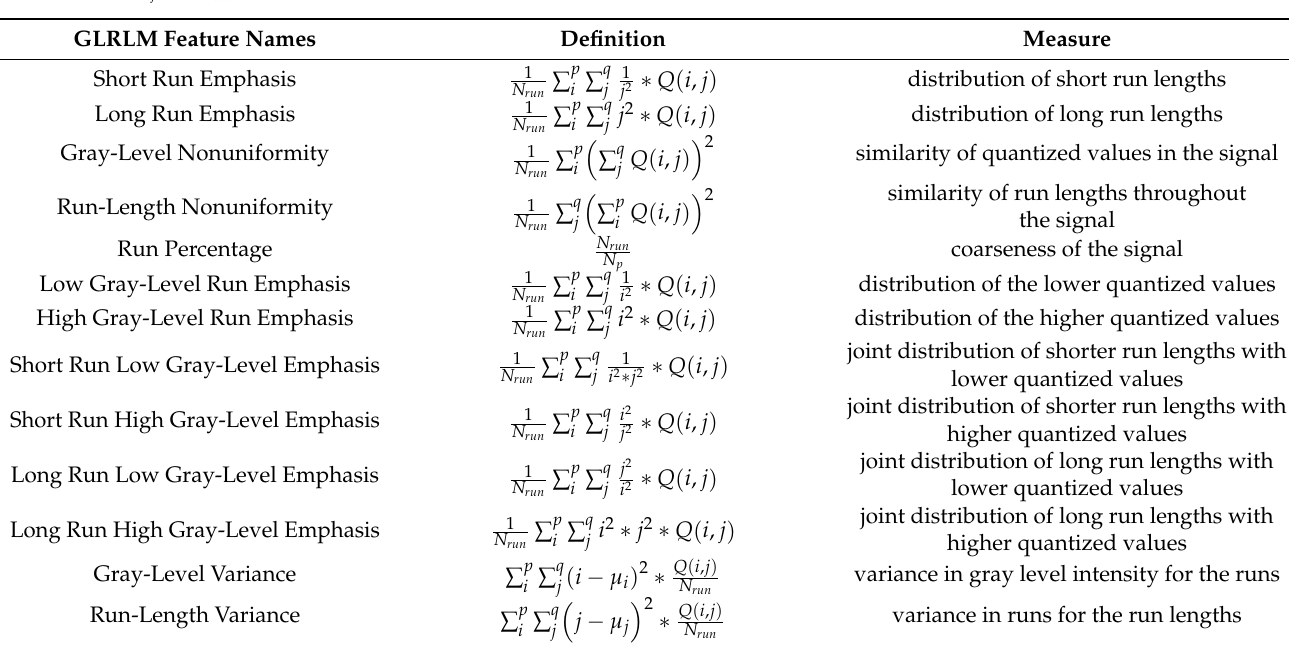
Table 3. GLRLM features. Q ( i , j ) is the GLRLM representing the number of runs of quantized gray level i and consec- utive length j . N run is the number of runs of the GLRLM and N p is the total signal length. µ i = ∑ p ∑ q j ∗ Q ( i , j ) µ j = ∑ p N run i j